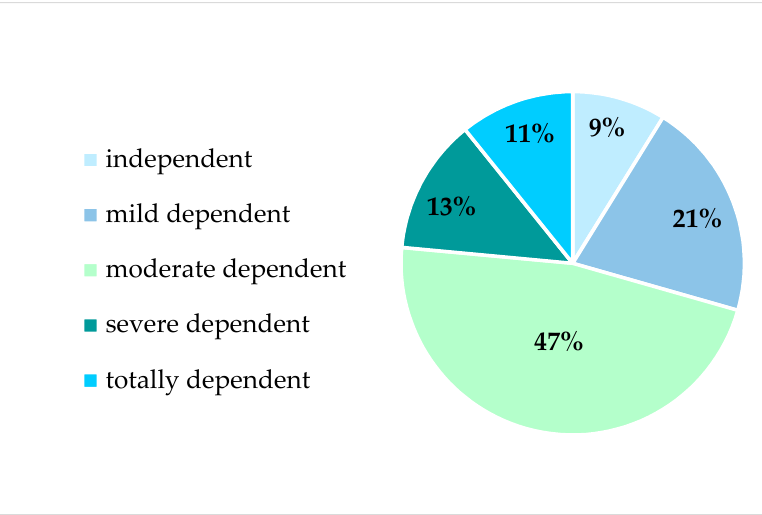
Figure 2. Study population characteristics—care recipient’s dependency level. Care recipients’ dementia stage was categorized as early (46%), middle (44%), and late (6%) stage dementia, with the majority of care recipients being moderately dependent (47%). The mean time since initial diagnosis was 2.2 years (SD = 1.9) and ranged from less